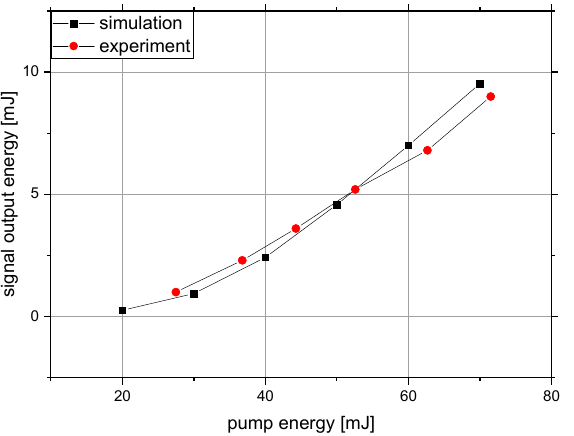
Figure 12. Measurement and simulation results of the signal output pulse energy of an OPA stage in dependency of the incident pump power. Table 5. Applied simulation values to best fit the experimental results.